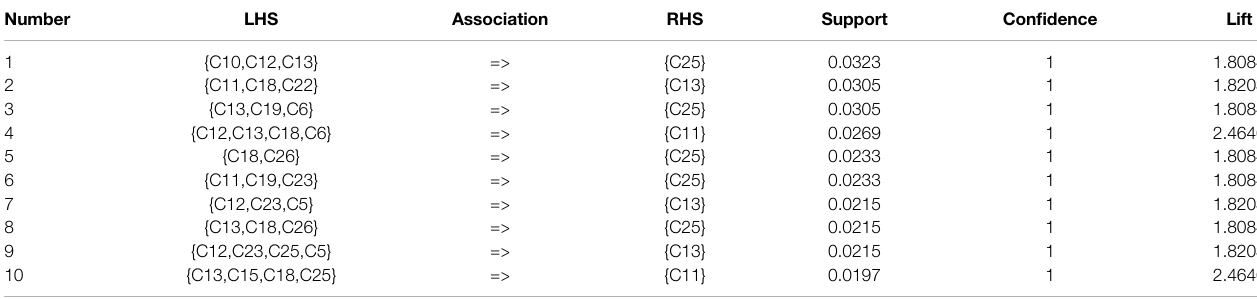
TABLE 3 | Results of the correlation analysis among the accident causal factors (part). Number